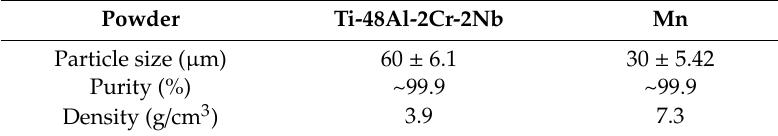
Table 1. Characteristics of Ti-48Al-2Cr-2Nb and Mn